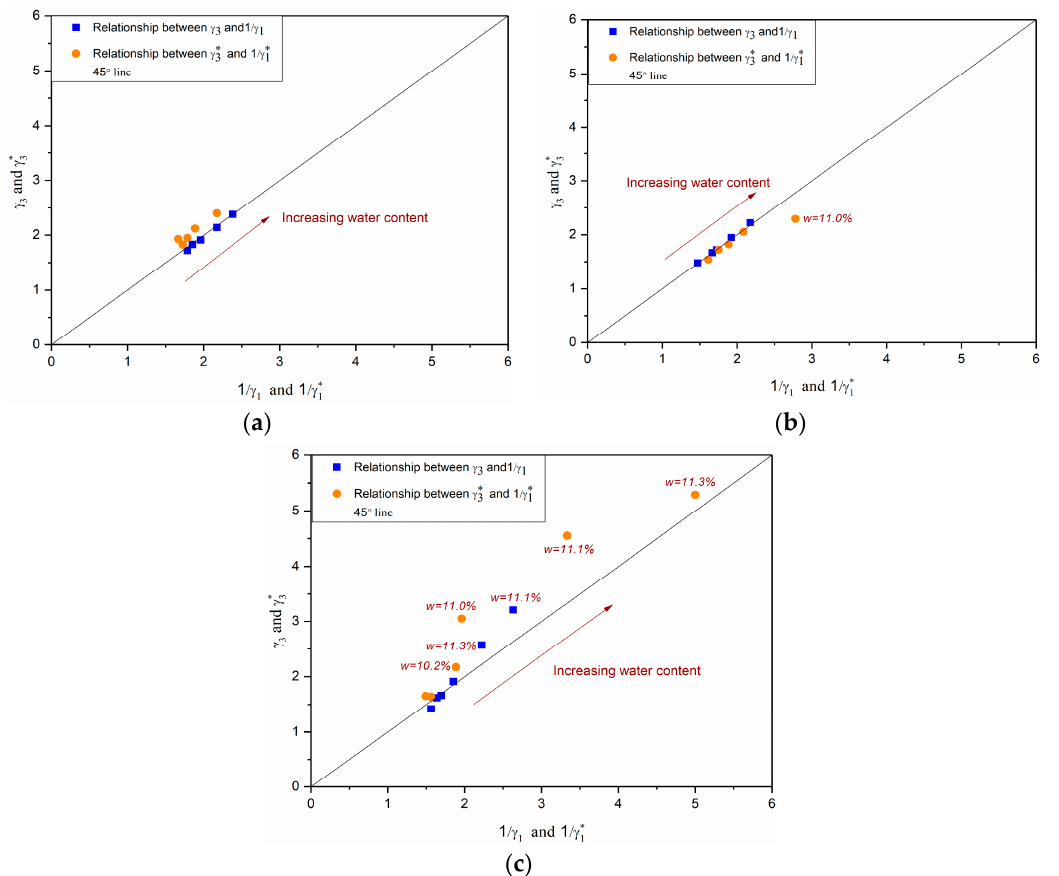
Figure 9. Relationships between γ 3 and 1/ γ 1 and γ 3 * and 1/ γ 1 * at water contents from 7% to 11%: ( a )